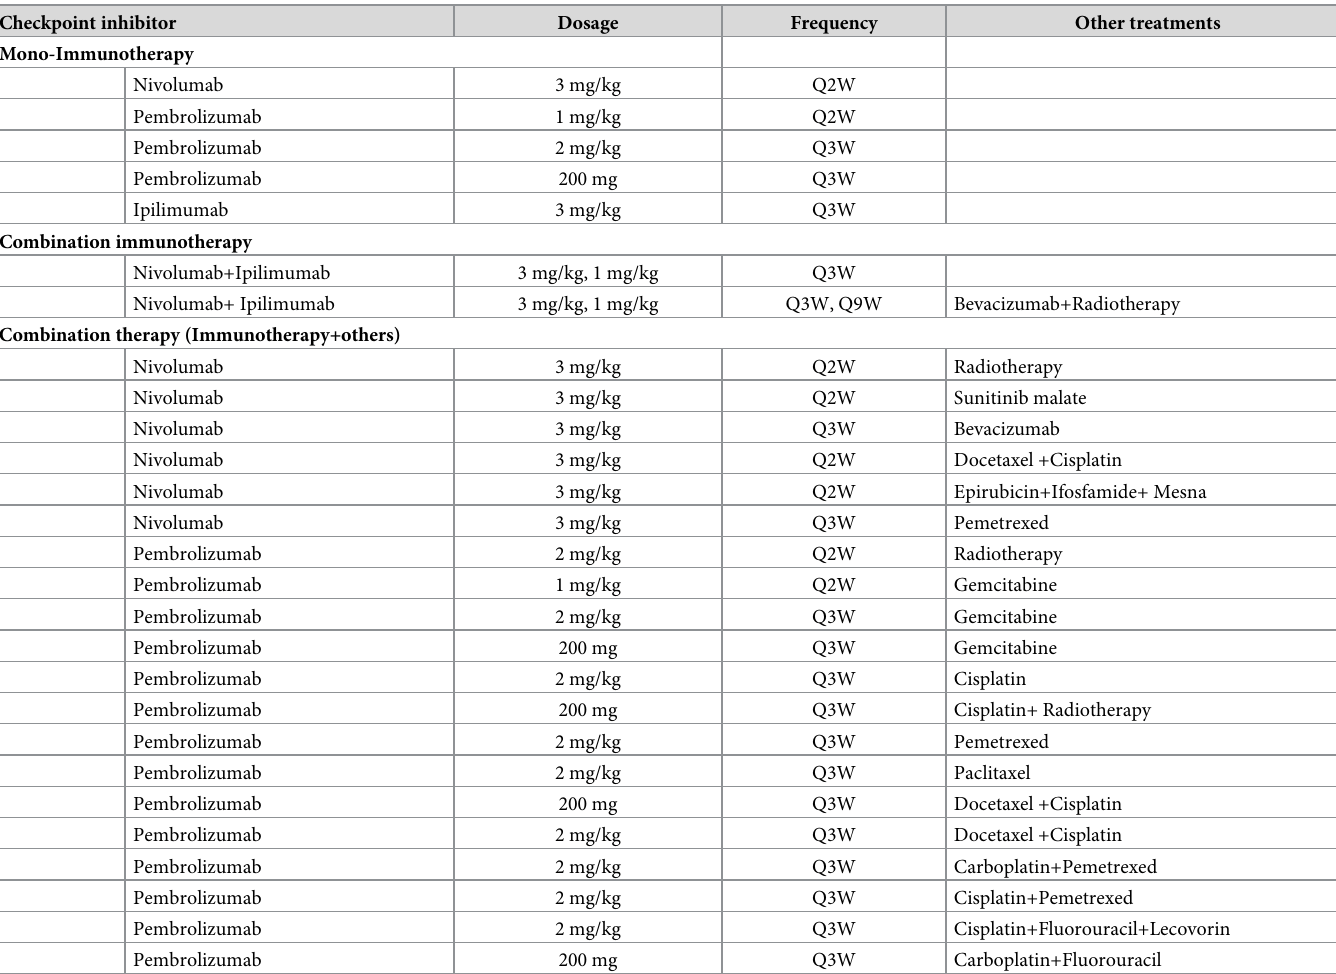
Table 3. Prescribing